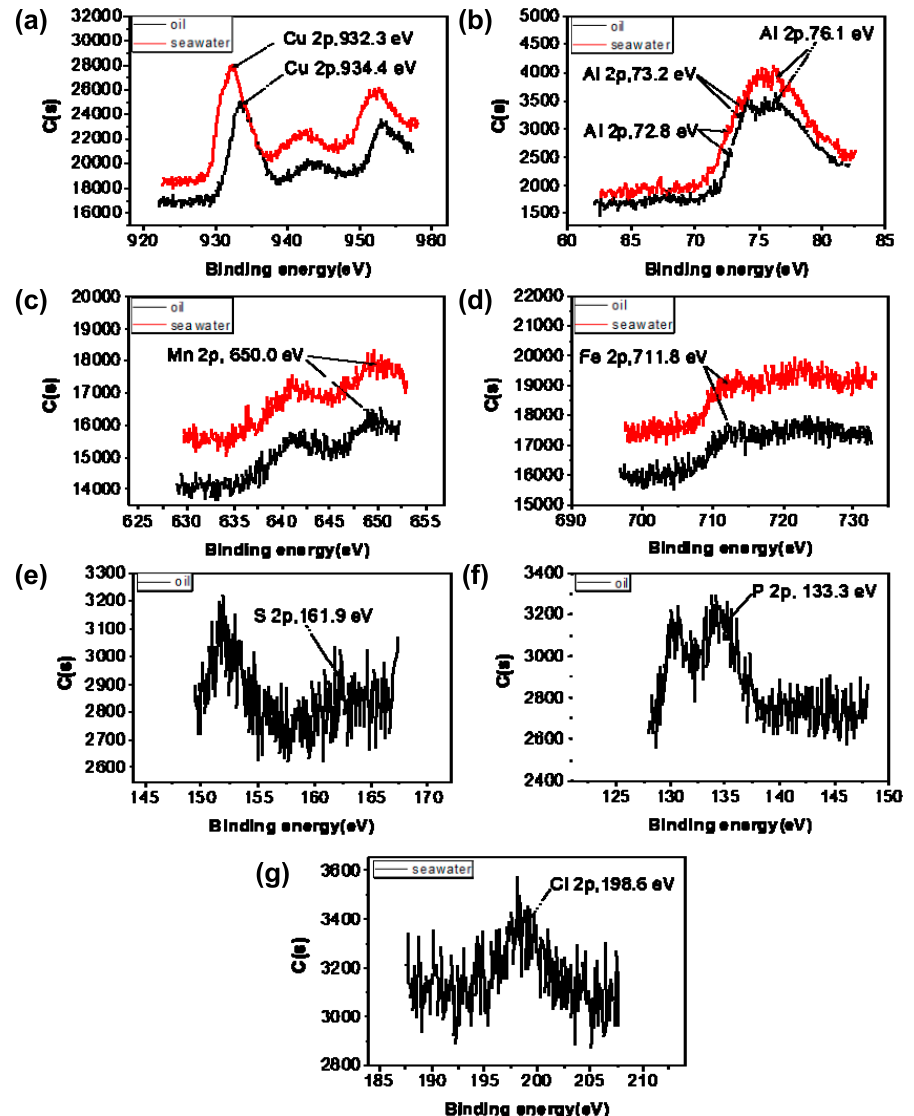
Figure 20. XPS spectra on the worn surfaces: ( a ) Cu 2p; ( b ) Al 2p; ( c ) Mn 2p; ( d ) Fe 2p; ( e ) S 2p; ( f ) P 2p; and ( g ) Cl 2p.